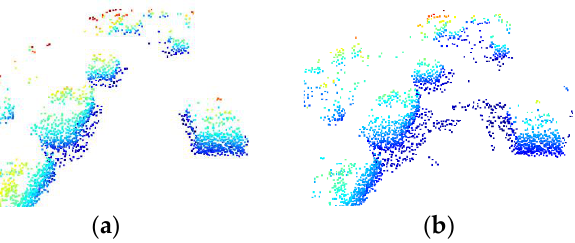
Figure 12. Effect of fusion feature on Predicted Keypoint Weighting (PKW). ( a ) Foreground point prediction with fusion feature. ( b ) Foreground point prediction without fusion feature. Table 6. Effects of different feature components.